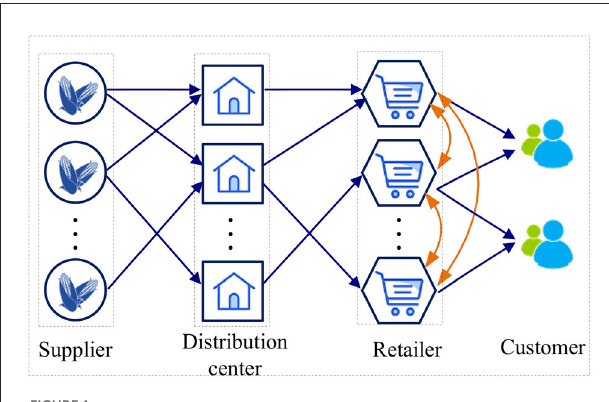
chain design. The decisions concern the selection of suppliers, the location of Distribution Centers (DCs), the allocation of suppliers to DCs and the allocation of DCs to retailers under different